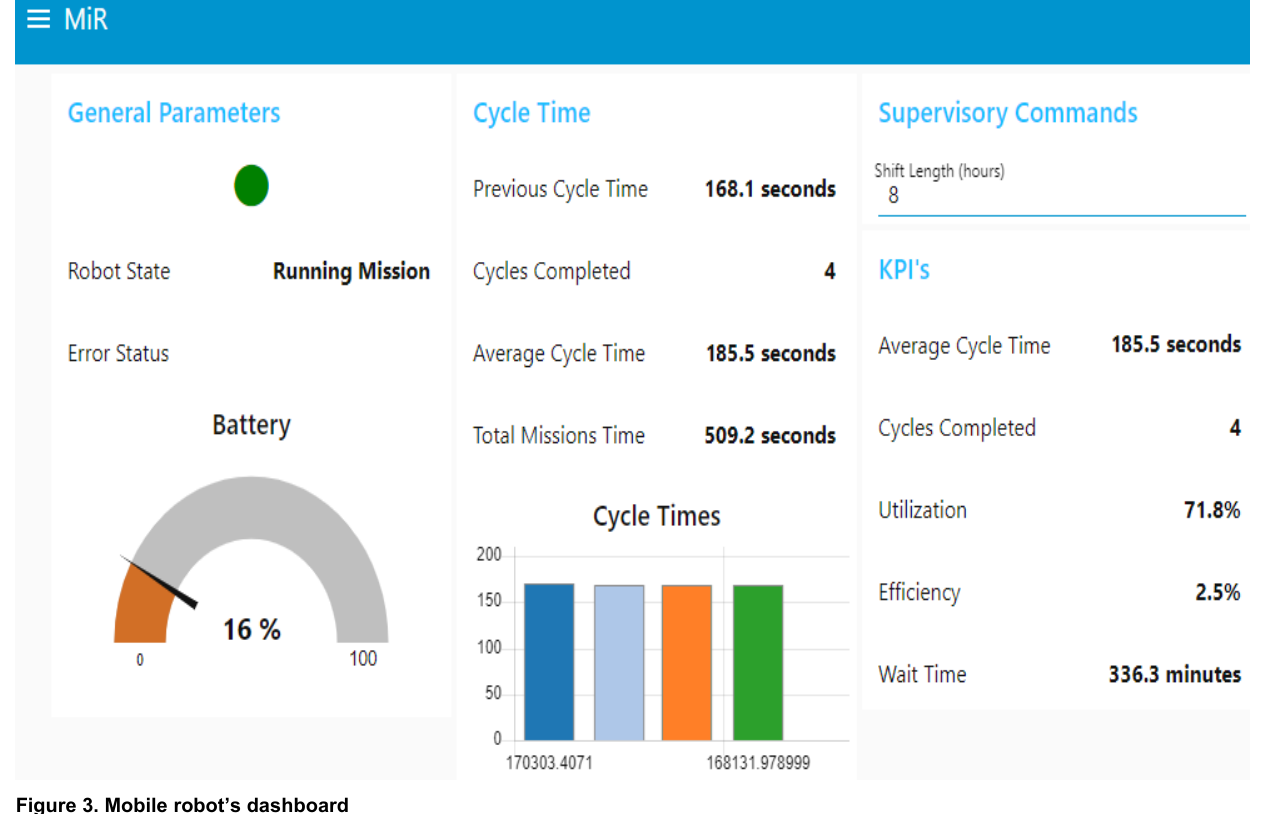
Figure 3. Mobile robot’s dashboard